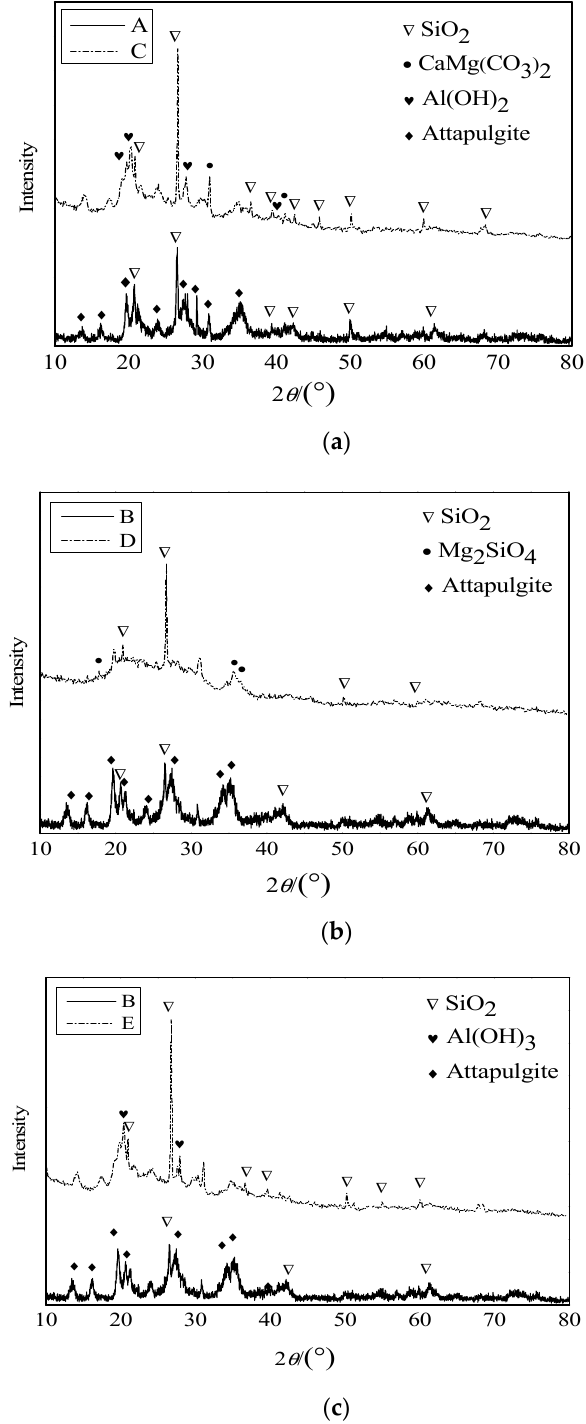
Figure 4. Phase changes in NAC before and after calcination. ( a ) Row ore under 650 °C calcined; ( b ) High-viscosity ore under 650 °C calcined; ( c ) High-viscosity ore under 750 °C calcined.